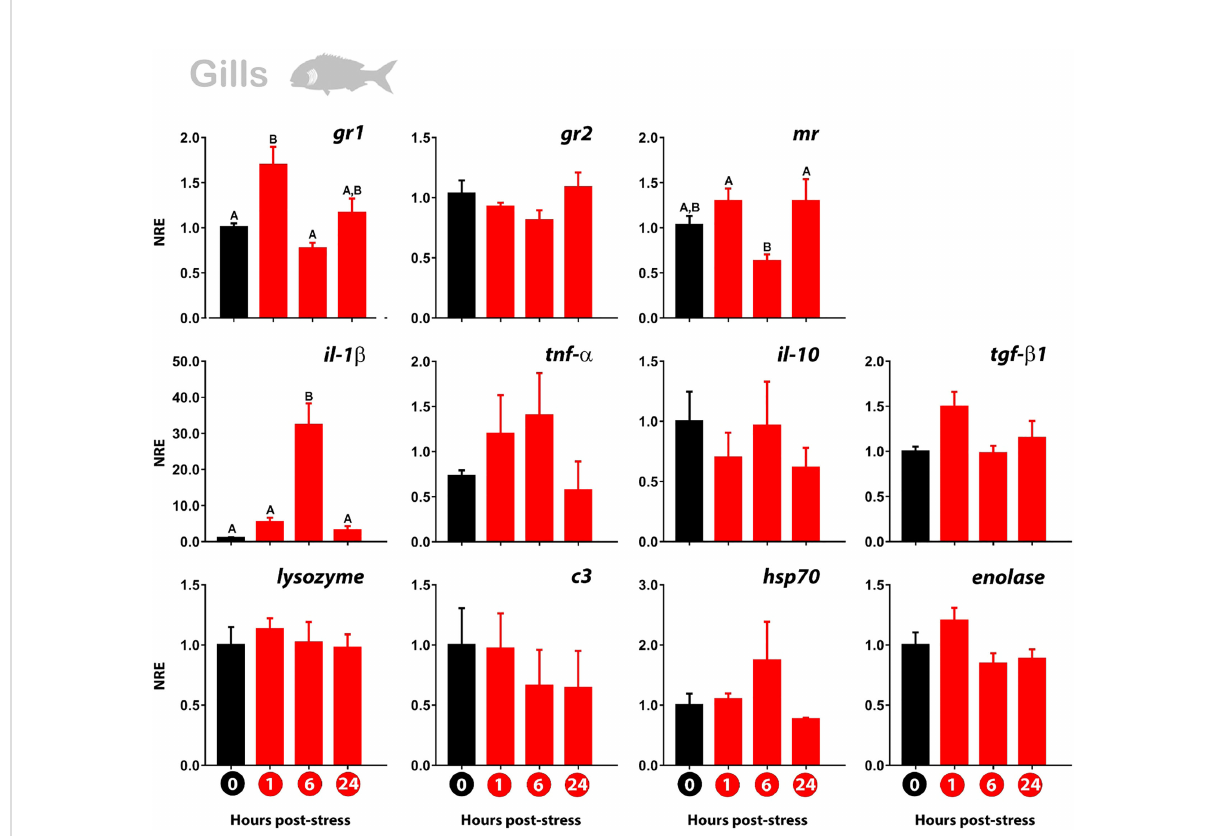
FIGURE 3 Normalized gene expression (NRE) pro fi le in the gills of gilthead sea bream subjected to acute stress by air exposure. Modulation of cortisol receptors ( gr1 , gr2 , mr ), immune ( il-1 b ; tnf- a ; il-10 ; tgf- b 1 ; lys ; c3 ), and stress response ( hsp70 ; enolase ) were evaluated by RT-qPCR. Bar values represent the mean ± standard error (n = 8 fi sh per treatment and time evaluated). Time zero represents the control group (non-stressed fi sh; black bar). The modulation of gene expression at 1 hour, 6 hours, and 24 hours post-stress (red bars) is represented. The rpl27 was used as reference gene. The signi fi cant differences between the different times are presented with a capital letter on each bar. The absence of letters indicates that there are no signi fi cant differences in the times evaluated (one-way Anova; p<0.05). gr1 , glucocorticoid receptor 1; gr2 , glucocorticoid receptor 2; mr , mineralocorticoid receptor; il-1 b , Interleukin 1-beta; tnf- a , tumor necrosis factor-alpha; il-10 , interleukin 10; tgf- b 1 , tumor growth factor-beta; lys , lysozyme; c3 , complement protein c3; hsp70 , heat shock protein